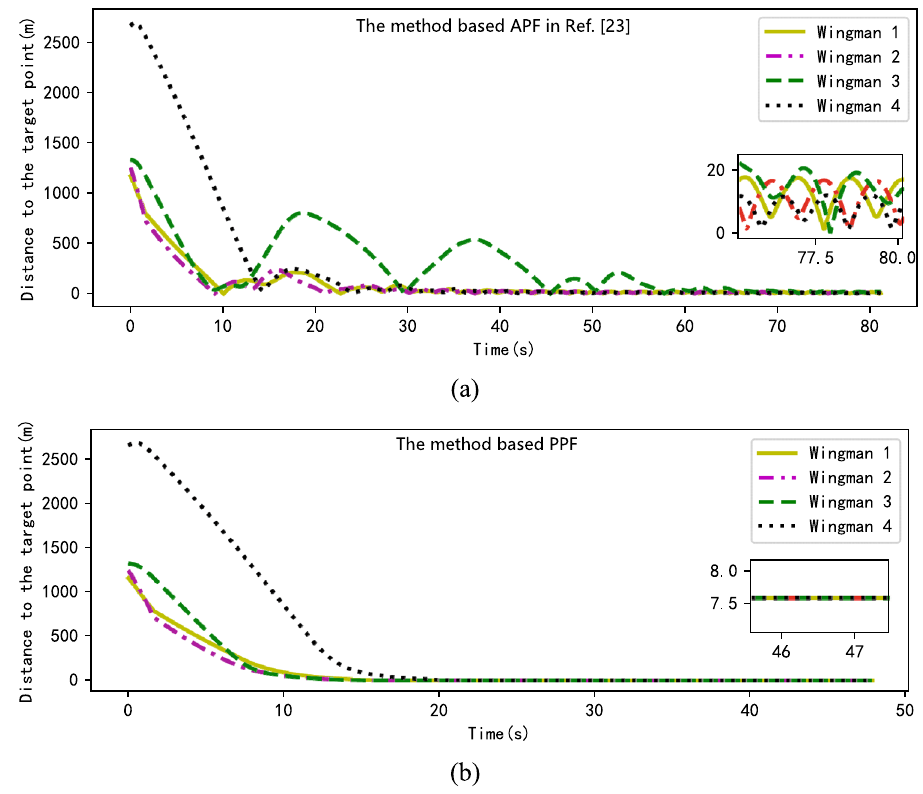
Figure 6. The situation of wingmen following the target points ( a ) Method proposed in Ref. 23 ; ( b ) method proposed in this paper.